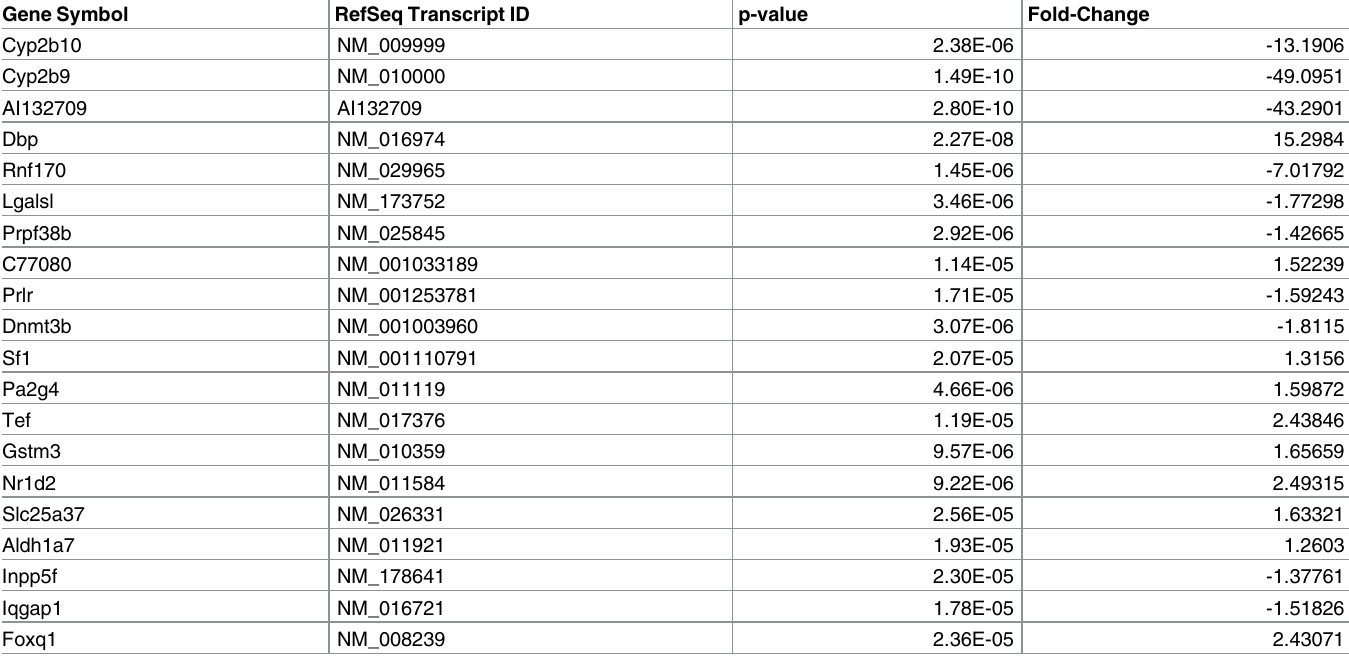
Table 4. Genes differentially expressedin Cyp2b9/10/13-null female mice compared to WT female mice following microarrayanalysis. Gene